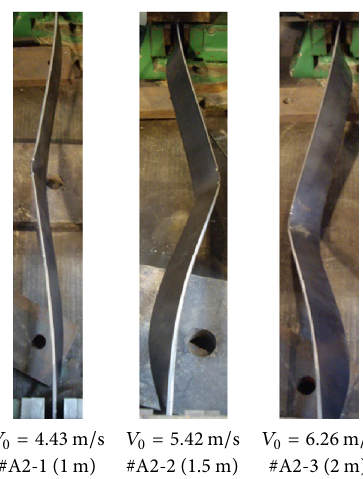
Figure 8: Deformation modes of #A2 (𝛼 = 10, 𝛽 = 15) .